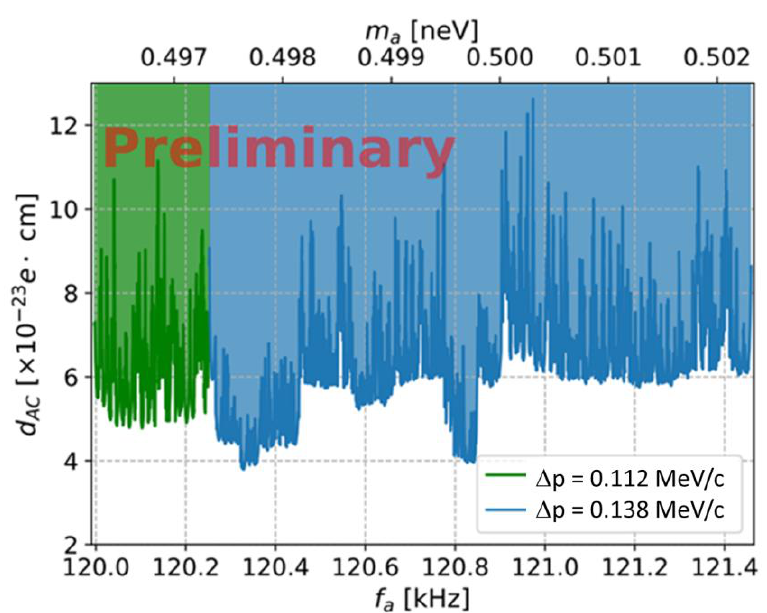
Figure 7. Preliminary result for the 90% confidence level sensitivity for excluding an ALP's induced oscillating EDM (oEDM) in the frequency range 120.0 – 121.4 kHz (corresponding to a mass range m a oscillating EDM (oEDM) in the frequency range 120.0–121.4 kHz (corresponding to a mass range = 0.496 – 0.502 neV/c 2 ). A dedicated paper has been submitted [38]. m a = 0.496–0.502 neV/c 2 ). A dedicated paper has been submitted